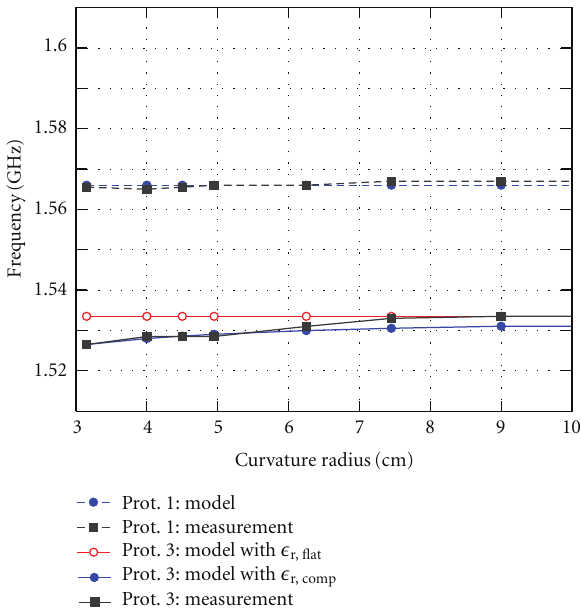
Figure 5: Resonance frequencies of prototypes 1 and 3 as a function of the bending radius when the antennas are bent along the L p